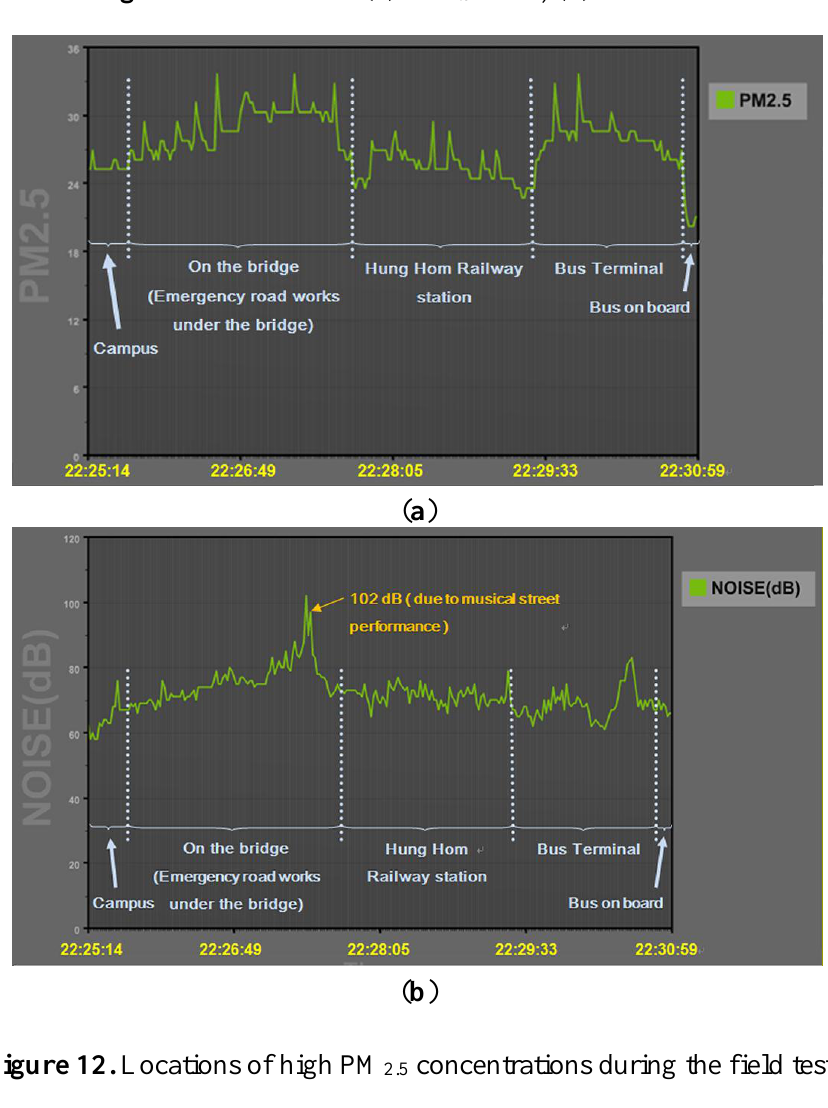
Figure 12. Locations of high PM 2.5 concentrations during the field tests.